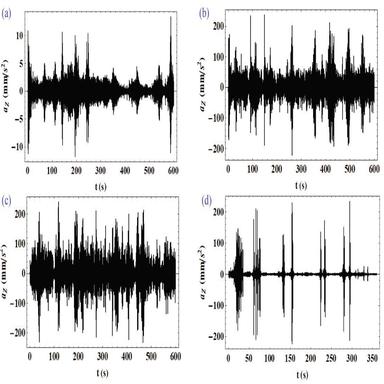
Example of typical record of the vertical acceleration.